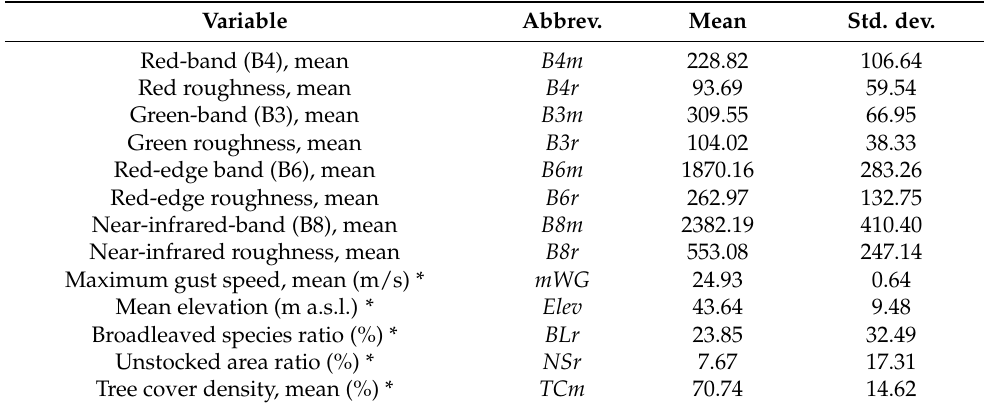
Table 1. Potential predictor variables and their brief descriptive statistics of mean and standard deviation within all sample polygons. The Sentinel-2-based spectral–spatial variables (S2 variables) refer to the arithmetic mean of pixel values within polygons derived from the mean composite images of the four pre-disturbance acquisition dates. The S2 variables and the Copernicus Forest (FTY and TCD 2015)-based variables were also calculated in a 60 m buffer zone around the polygons; by such usage, suffix (b) is added to the variable abbreviations. Variables marked with * are used as benchmark variables based on publicly available derived spatial data products. Variable Abbrev. Mean Std.